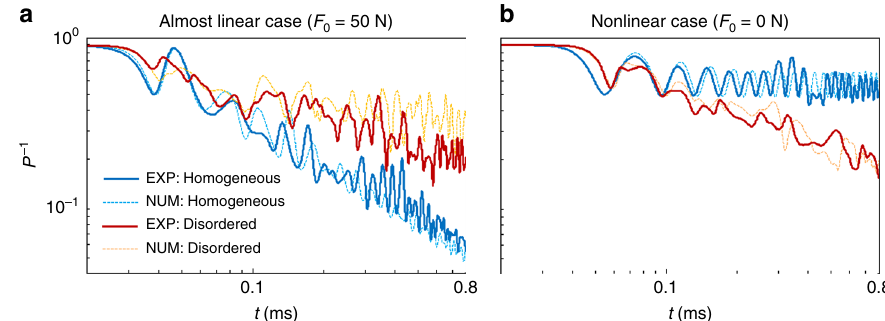
Fig. 4 Energy-localization characteristics. Inverse participation ratio ( P − 1 ) of the kinetic energy in homogeneous (blue curves) and disordered (red curves) chains for ( a ) almost linear and ( b ) nonlinear regimes. In both cases, we compare numerical calculations (dashed curves) with experimental data (solid